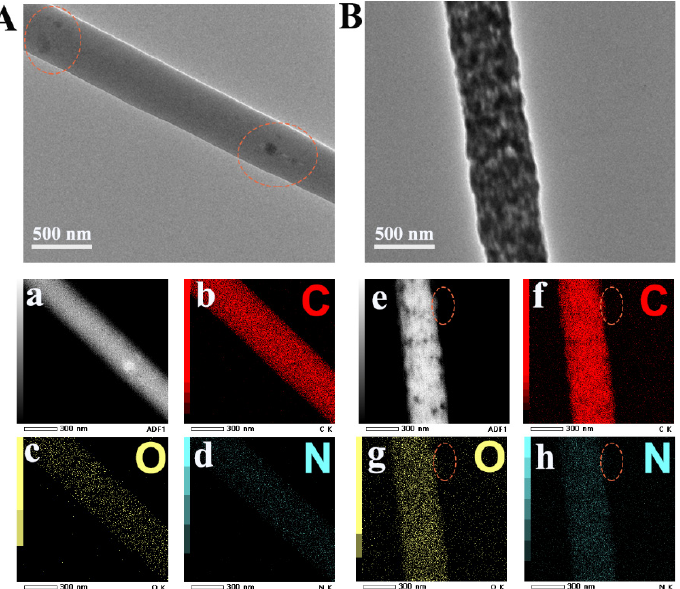
Figure 3. TEM images of PEN − P − PCDA − 80 °C ( A ) and PEN − B − PCDA − 80 °C ( B ) and elemental mappings of PEN − P − PCDA − 80 °C ( a – d ) and PEN − B − PCDA − 80 °C ( e – h ).